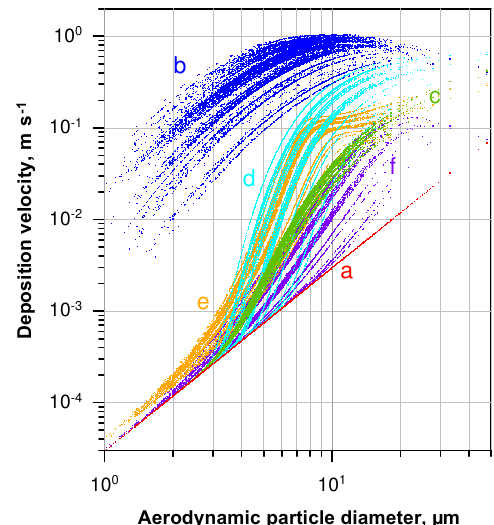
Figure 4. Deposition velocity to a smooth surface calculated by different deposition models for the samples of 2013, taking into account the ambient thermodynamic conditions and the particle composition. (a) Stokes settling; (b) Noll et al. (2001); (c) Noll and Fang (1989); (d) Aluko and Noll (2006); (e) Piskunov (2009); (f) Wagner and Leith